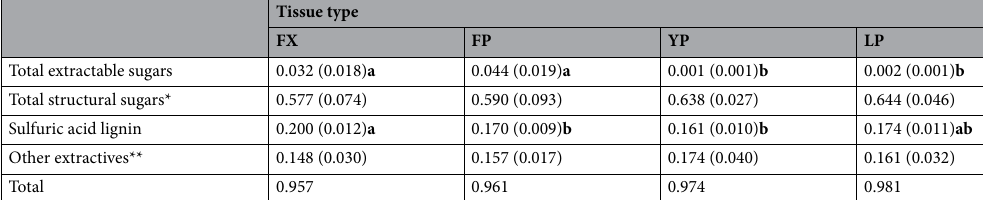
Table 1. Weight ratios of tissue components of Pleioblastus simonii bamboo internodes. Each value represents the mean (SD) of five internode samples. Different letters in bold indicate significant differences among tissue types by the Steel–Dwass test ( P < 0.05) after the Kruskal–Wallis test ( P < 0.05). No bold letters indicate no significant differences among tissue types by the Kruskal–Wallis test ( P > 0.05) except for the total. FX fresh xylem, FP fresh pith, YP pith on which Wickerhamomyces anomalus yeast had grown, LP pith on which W. anomalus and a larva of Doubledaya bucculenta had grown. *Recalculated as dehydrated structures according to sugar analyses (see Table 2). **Calculated by subtraction of total extractable sugars from total